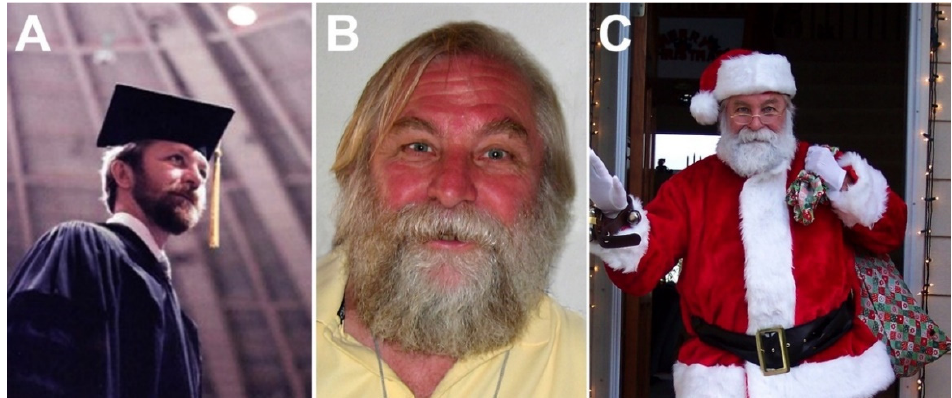
Figure 1. Photographs of Randall Cohrs during his career. ( A ). Graduation ceremony at Southern Illinois University in 1985. ( B ). Taking a break at a virology meeting in 2008. ( C ). Randy dressed as Santa Claus for a favorite children’s event in Lakewood, Colorado, in 2013.